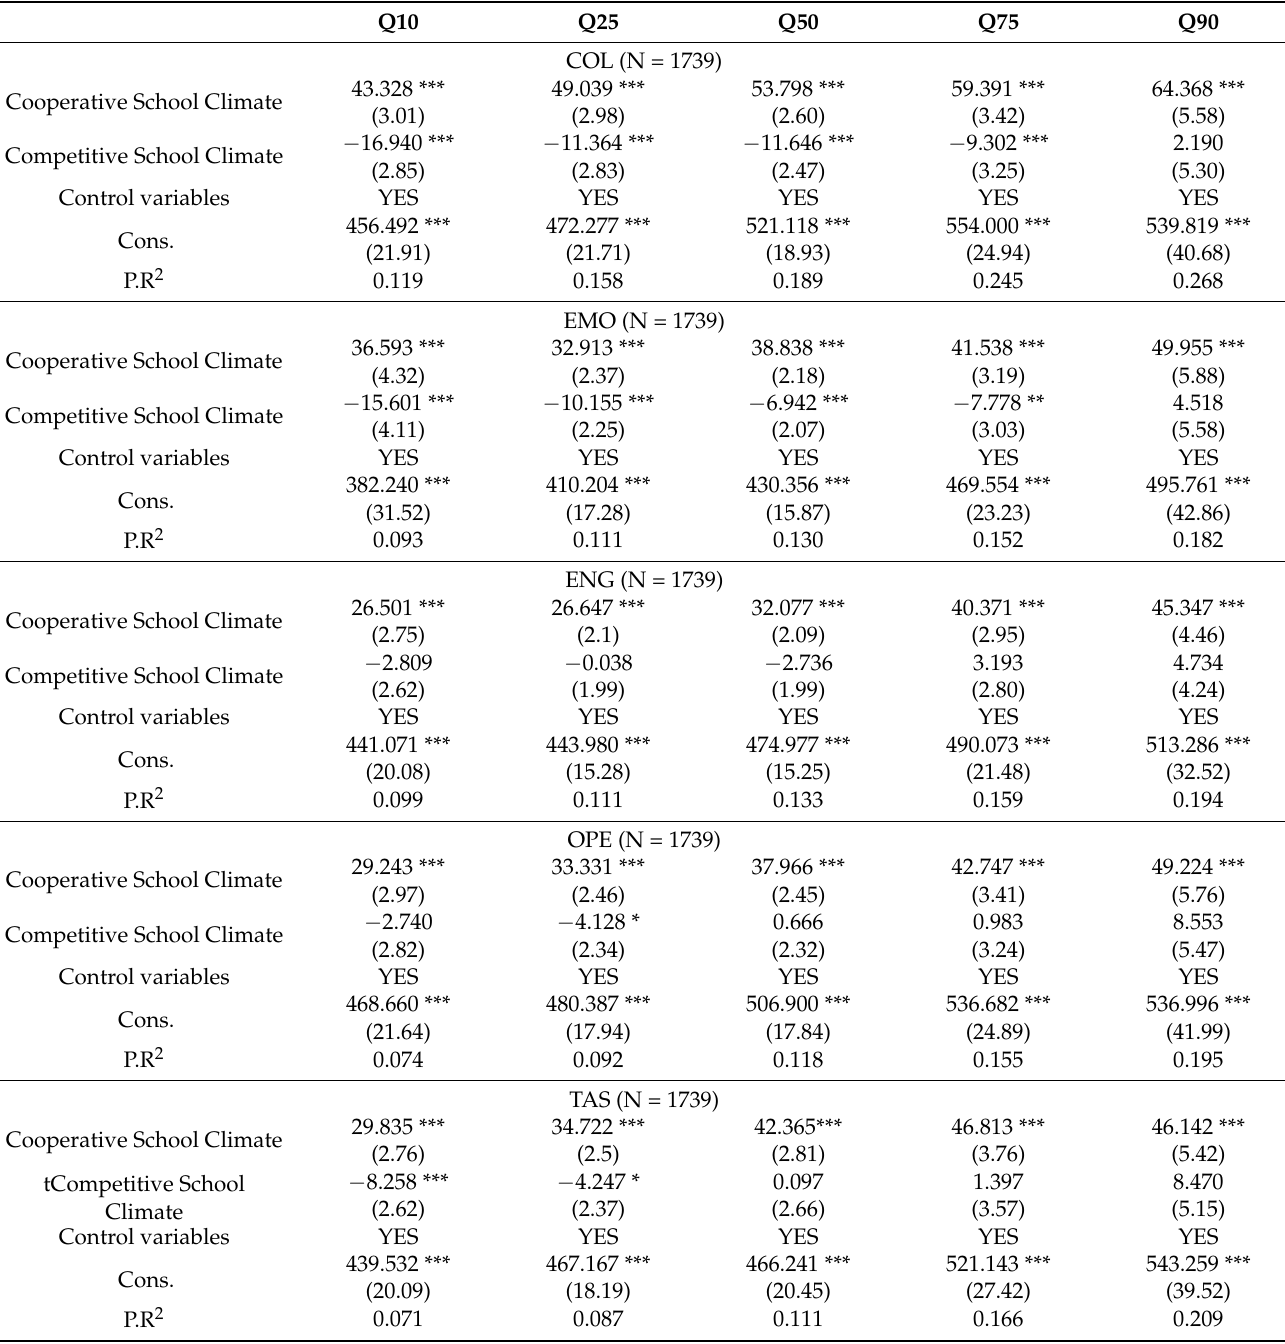
Table 3. Results of the quantile regression analysis